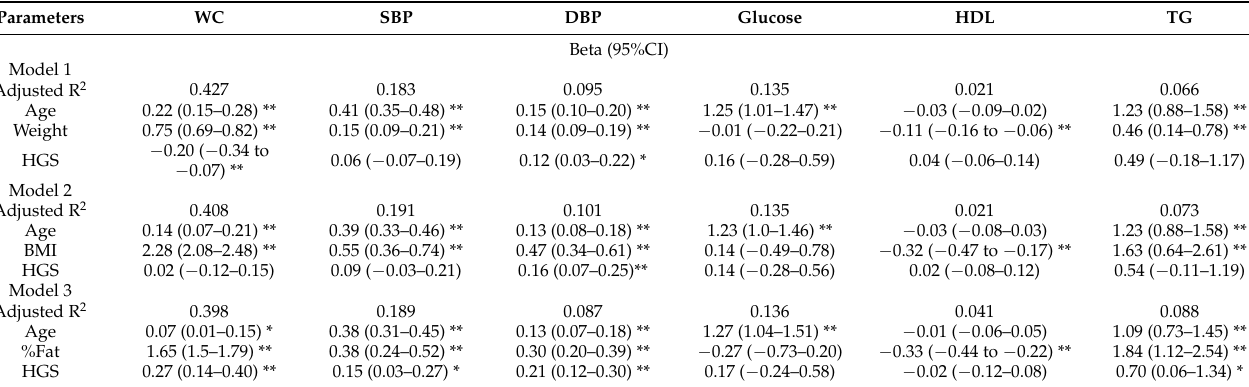
Table 3. Linear regression analysis for metabolic syndrome components with age, handgrip strength, and body composition.